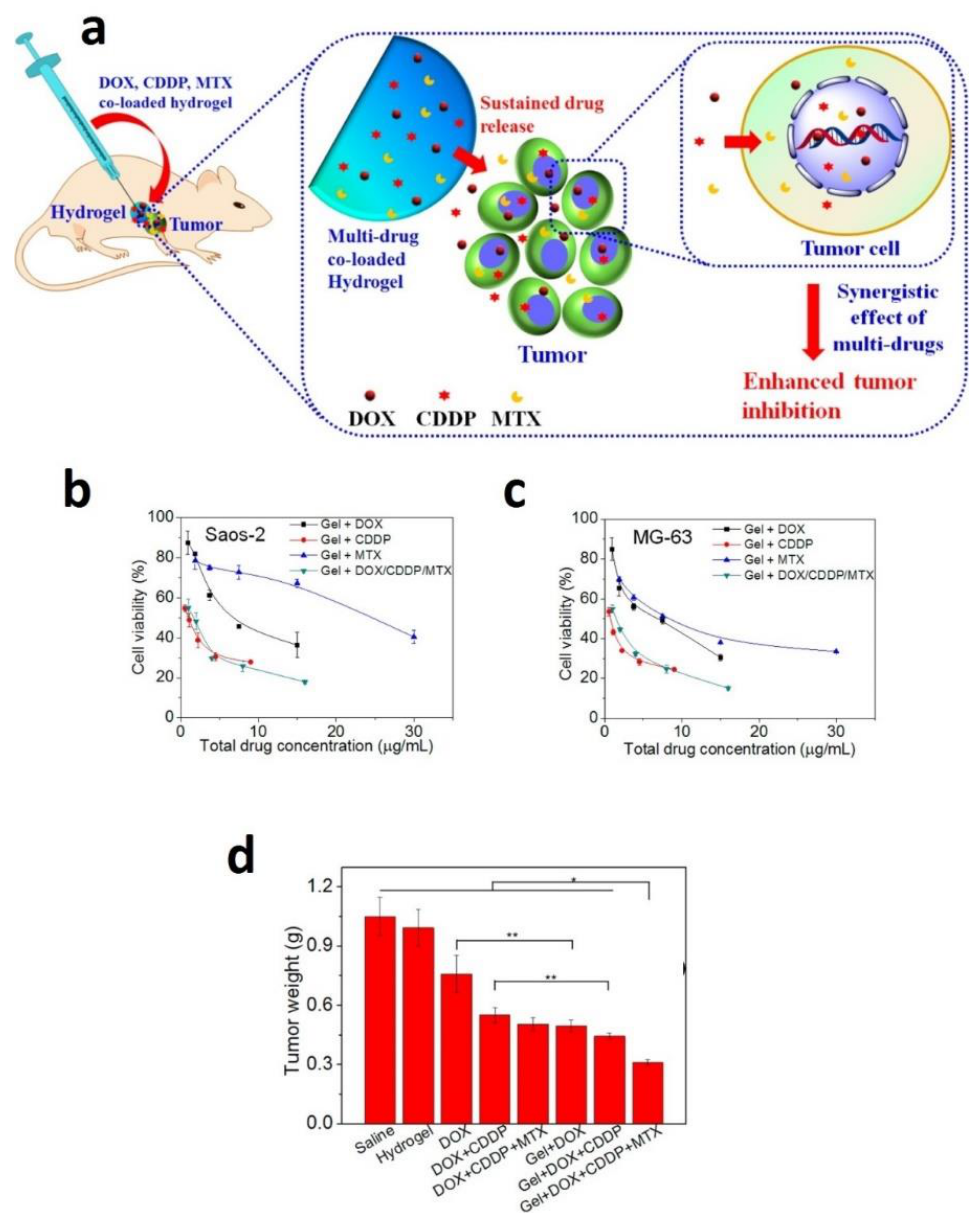
Figure 5. ( a ) Schematic illustration of the localized and sustained co-delivery of DOX, CDDP, and MTX using PLGA-PEG-PLGA hydrogels for synergistic treatment of tumor. ( b , c ) Cytotoxicity of the hydrogels containing the single drug or multiple drugs against Saos-2 or MG-63 cells, after incubation for 48 h. ( d ) Tumor weights obtained from the BALB/c nude mice bearing human osteosarcoma Saos-2 xenografts after single injection to the vicinity of the tumors at day 16. Data were presented as mean ± standard deviation ( n = 6). (* p < 0.05, ** p < 0.01) [133]. Reprinted with the permission from ACS Applied Materials & Interfaces. Copyright American Chemical Society, 2015.